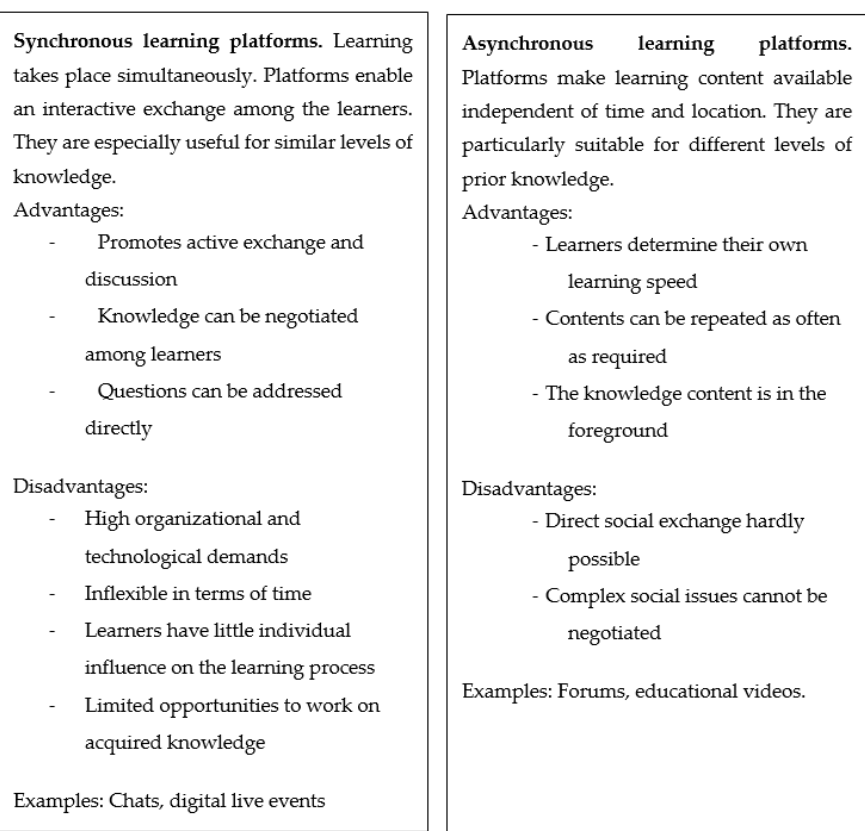
Figure 1. Advantages and disadvantages of synchronous and asynchronous digital teaching aids.